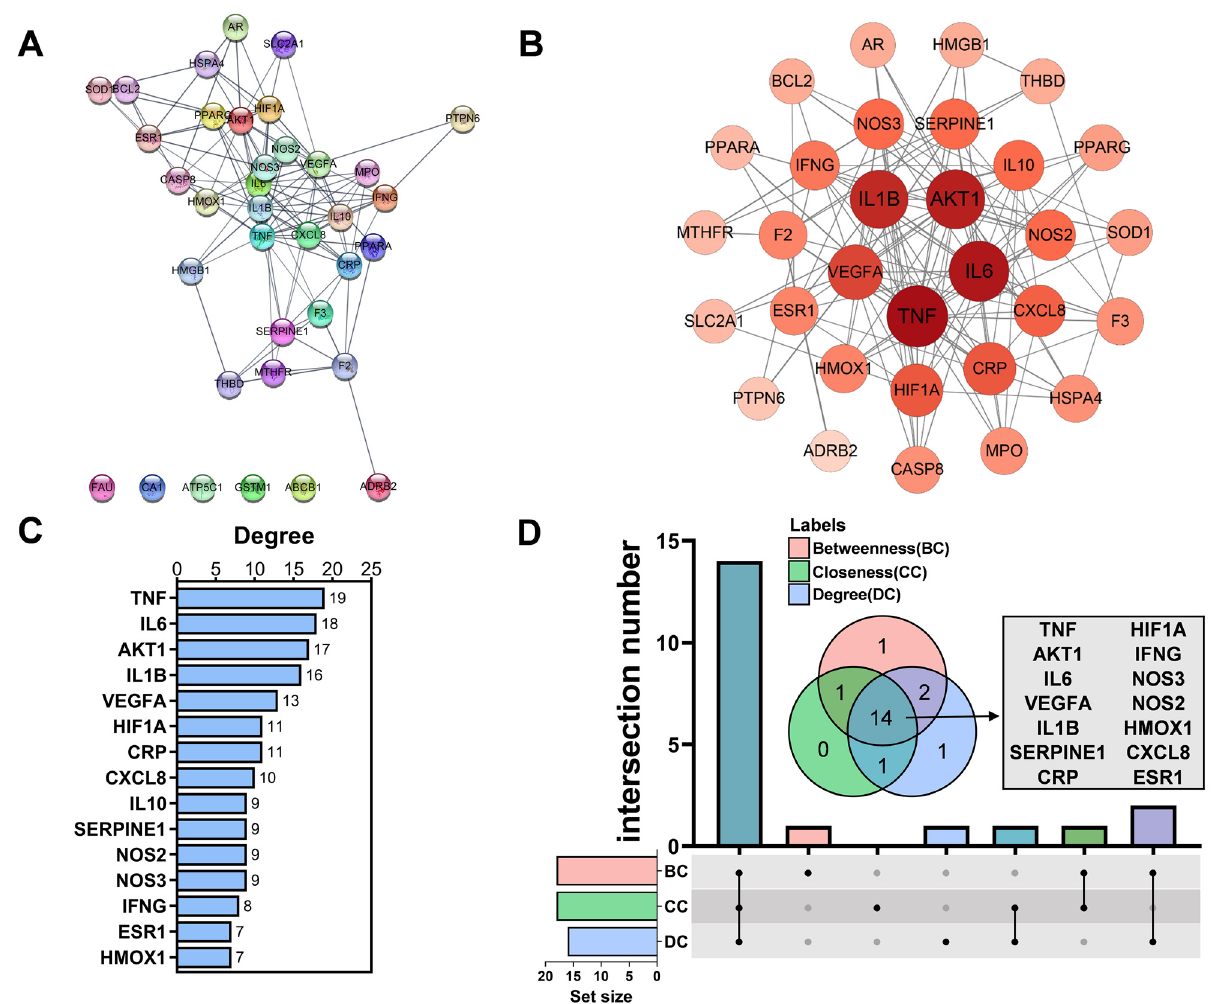
Figure 5. Obtained core targets of AM towards HAPC. ( A ) PPI network of drug–disease intersection targets. The minimum required interaction score was set to 0.7 by the STRING database. ( B ) Visualization of the PPI network by Cytoscape. No-edge nodes have been removed. ( C ) Top 15 targets in the PPI network ranked by degree. ( D ) Venn diagram showed the core targets. Targets meeting BC ≥ 10.95 (median), CC ≥ 0.145 (median), and DC ≥ 7 (median) were screened.